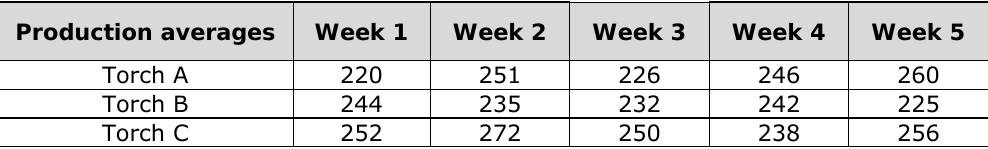
Table 10. “Weekly averages of production by the